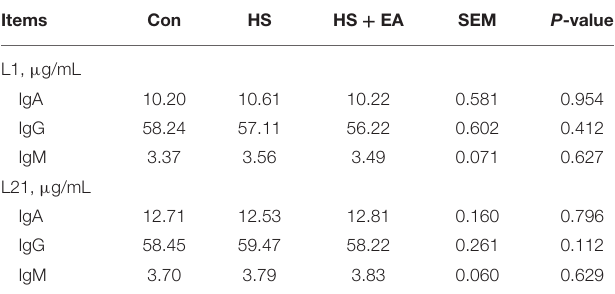
TABLE 9 | Effects of maternal dietary supplementation with EA on immunoglobulin levels in the serum of nursing piglets.